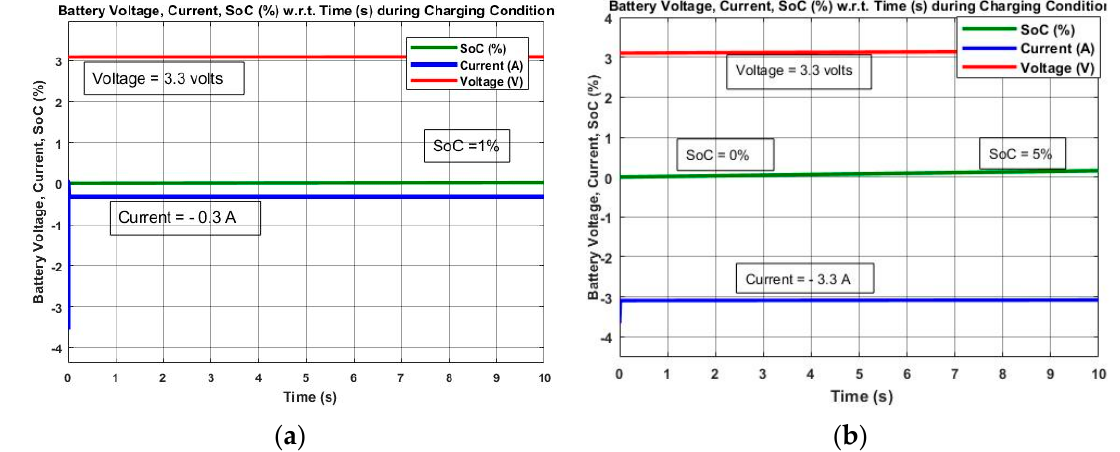
Figure 10. Simulation results of PWM controlled and P&O MPPT controlled solar energy harvesting (SEH) system for 10 s. ( a ) Battery SoC, Voltage and Current during Charging using PWM control; ( b ) Battery SoC, Voltage and Current during Charging using P&O MPPT control.